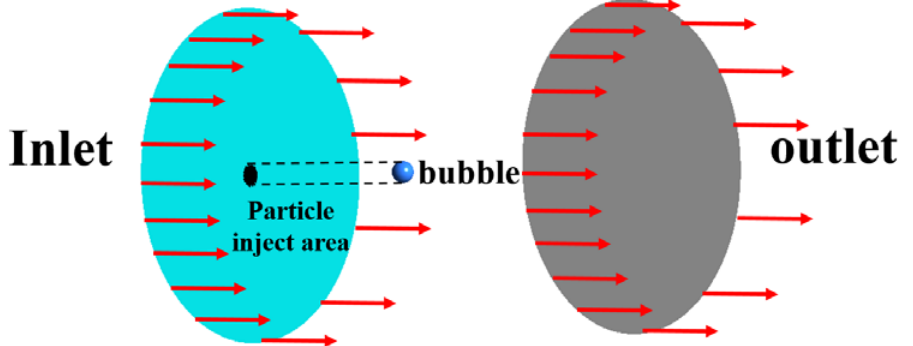
Figure 3. Computational fluid mechanics model and particle tracking scheme for analyzing bubble-particle collisions.